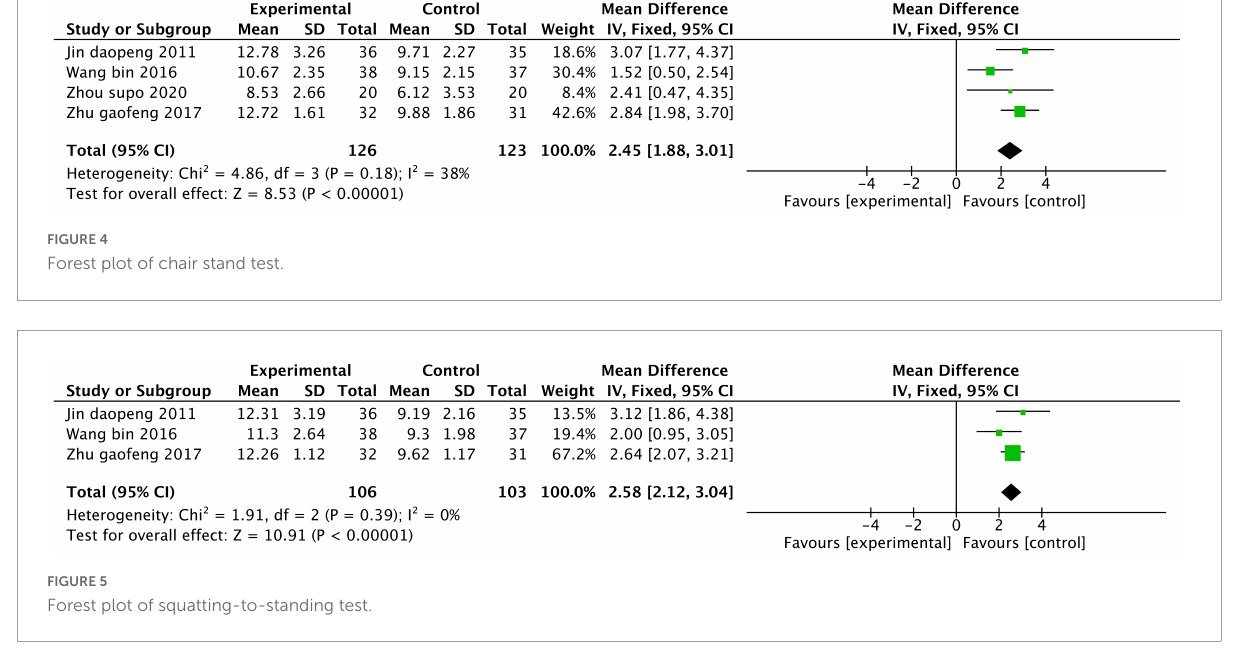
FIGURE6 Forest plot of 6-m gait speed.